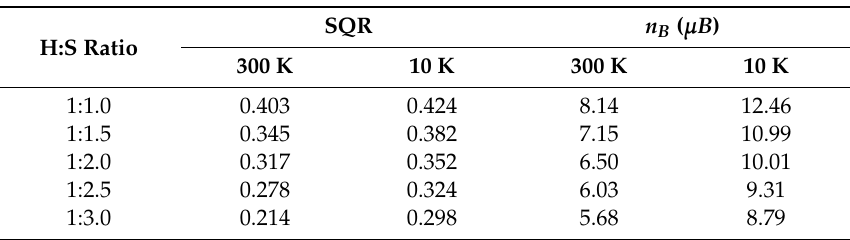
Table 2. Squareness ratio (SQR) and magneton numbers ( n B ) of the hard / soft ferrite products